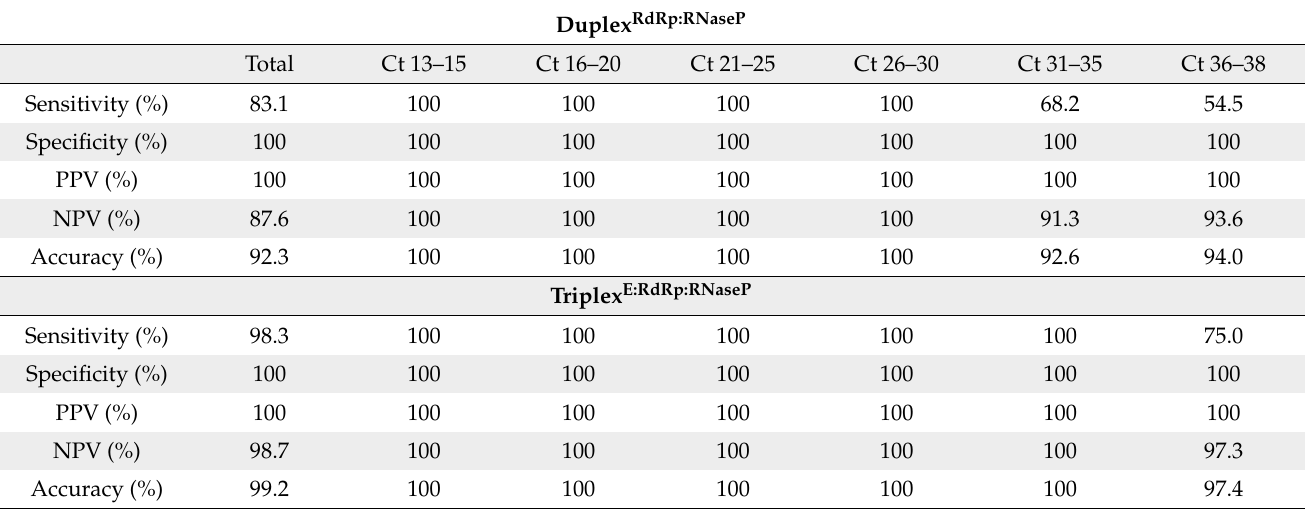
Table 3. Relationship of the sensitivity, specificity, accuracy, and positive and negative predictive values between the Ct heat ranges of the standard test for the RdRp duplex RT-qPCR and RdRp Triplex E RT-qPCR diagnostic assays, including 59 positive samples and 73 negative samples. Duplex